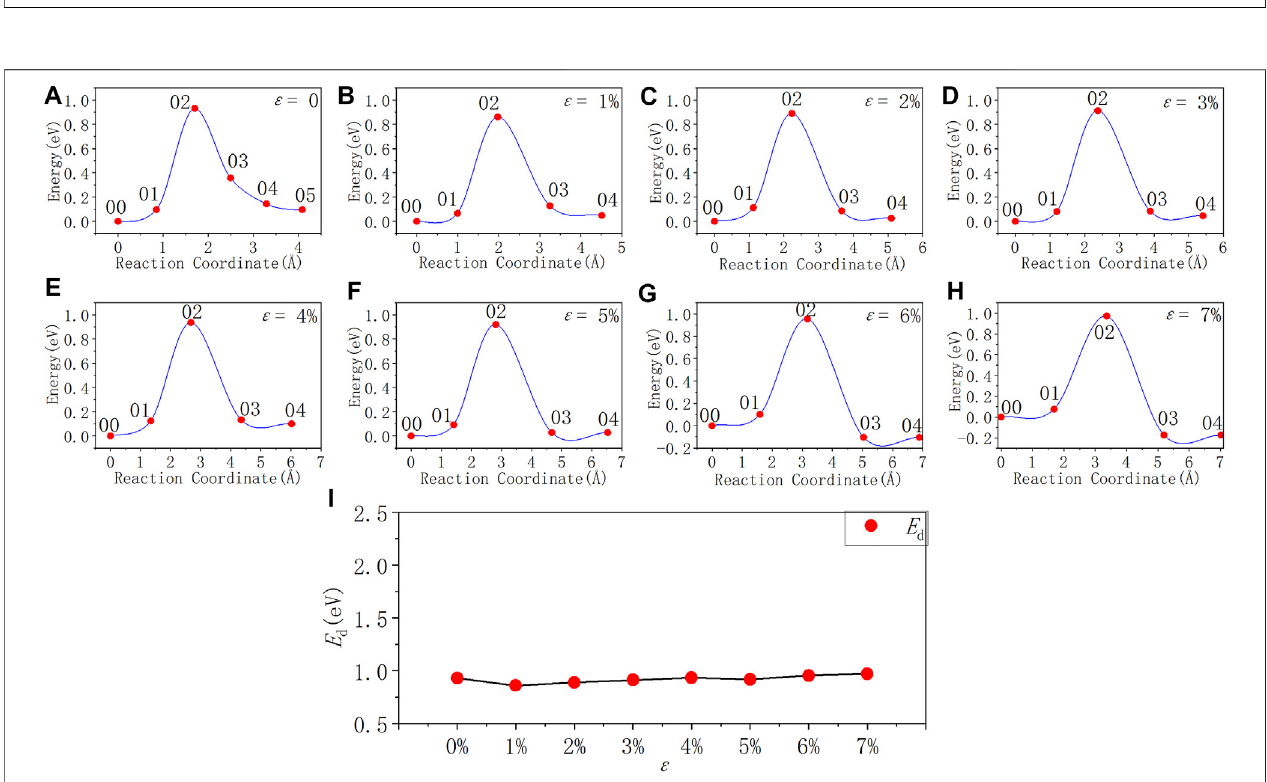
FIGURE8| Reactionenergycurvesandactivationenergypro fi lecurveofthe P b1 defectdepassivation; (A – H) exhibitdepassivationreactionenergycurvesundera tensile strain range of 0%~7%, and (I) exhibits the activation energy pro fi le curve.